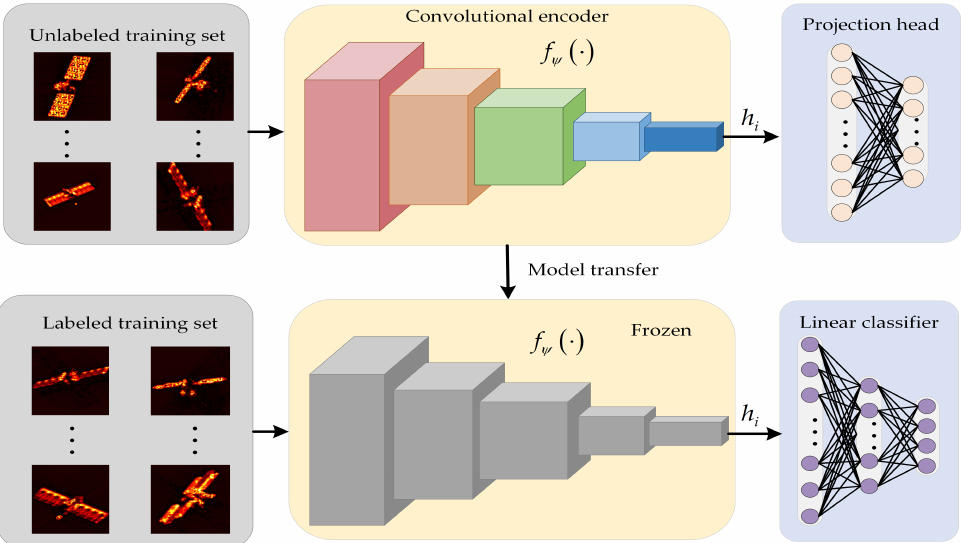
Figure 7. Diagram of classifier fine-tuning in